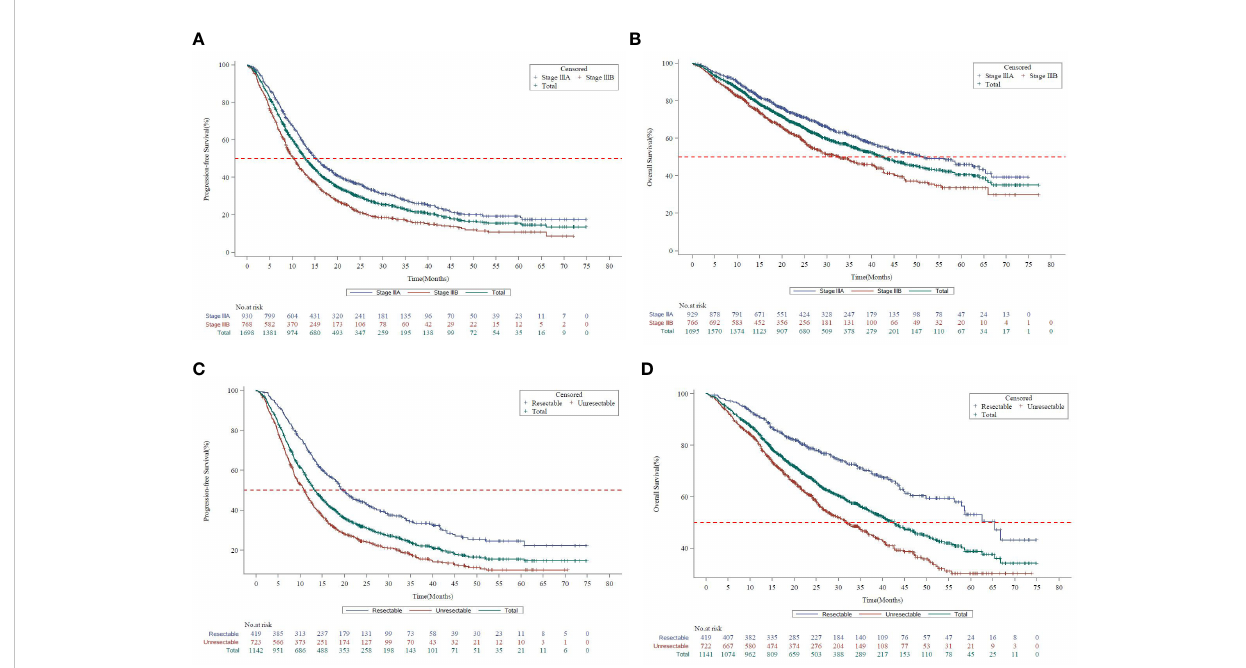
FIGURE 1 Survival curves by disease stage in KINDLE-Asia. (A) Kaplan-Meier survival curves for progression-free survival by disease stage (AJCC 7 th Edition). AJCC=American Joint Committee on Cancer; CI=Con fi dence interval; mPFS=Median progression-free survival; NSCLC=Non-small cell lung cancer. Kaplan-Meier Survival curves for progression-free survival for all stage III NSCLC patients are shown in green, whereas stage IIIA and stage IIIB patients are shown in blue or red, respectively. mPFS for the entire cohort, 12.8 months (95% CI, 12.19 to 13.70). mPFS for stage IIIA, 15.1 months (95% CI, 14.03 to 16.56). mPFS for stage IIIB, 10.3 months (95% CI, 9.26 to 11.27). (B) Kaplan-Meier survival curves for overall survival by disease stage (AJCC 7 th Edition). AJCC=American Joint Committee on Cancer; CI=Con fi dence interval; mOS=Median overall survival; NSCLC=Non-small cell lung cancer. Kaplan-Meier survival curves for overall survival for all stage III NSCLC patients are shown in green, whereas stage IIIA and stage IIIB patients are shown in blue or red, respectively. mOS for the entire cohort, 42.3 months (95% CI, 38.08 to 46.75). mOS for stage IIIA, 51.4 months (95% CI, 43.83 to 64.07). mOS for stage IIIB, 32.8 months (95% CI, 27.66 to 40.61). (C) Kaplan-Meier survival curves for progression-free survival by resection status. CI=Con fi dence interval; mPFS=Median progression-free survival; NSCLC=Non-small cell lung cancer. Kaplan-Meier survival curves for progression-free survival for all stage III NSCLC patients are shown in green, whereas resectable and unresectable patients are shown in blue or red, respectively. mPFS for the entire cohort, 12.8 months (95% CI, 12.19 to 13.70). mPFS for resectable patients, 19.8 months (95% CI, 18.00 to 22.67). mPFS for unresectable patients, 11.0 months (95% CI, 9.66 to 11.86) (D) Kaplan-Meier survival curves for overall survival by resection status. CI=Con fi dence interval; mOS=Median overall survival; NSCLC=Non-small cell lung cancer. Kaplan-Meier survival curves for overall survival for all stage III NSCLC patients are shown in green, whereas resectable and unresectable patients are shown in blue or red, respectively. mOS for the entire cohort, 42.3 months (95% CI, 38.08 to 46.75). mOS for resectable patients, 65.4 months (95% CI, 57.86 to Not Calculable). mOS for unresectable patients, 31.8 months (95% CI, 27.40 to